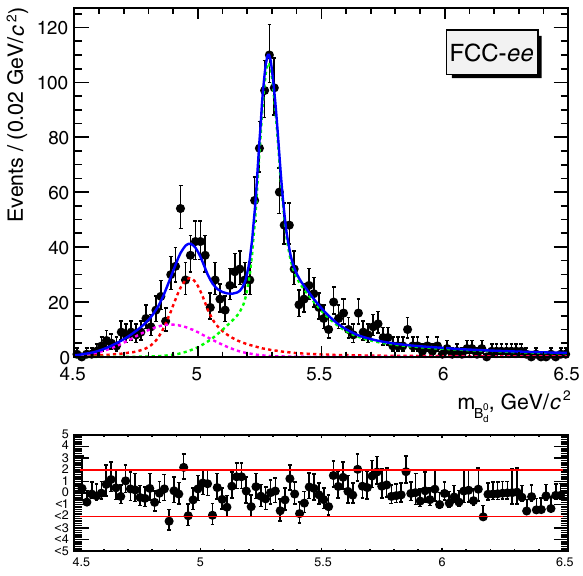
Fig. 2 Invariant mass reconstruction of ¯ B 0 → K ∗ 0 ( 892 )τ + τ − candi- dates.The τ particlesaredecayingintothreeprongs τ − → π − π + π − ν τ allowing the τ decay vertex to be reconstructed. The primary vertex ( Z vertex) is reconstructed from primary tracks and the secondary ver- tex ( ¯ B 0 vertex) is reconstructed thanks to the K ∗ ( 892 ) daughter par- ticles ( K ∗ ( 892 ) → K + π − ). Two dominant sources of backgrounds are included in the analyzed sample, namely ¯ B s → D + s D − s K ∗ 0 ( 892 ) and ¯ B 0 → D + s ¯ K ∗ 0 ( 892 )τ − ¯ ν τ . They are modeled by the red and pink probability density functions (p.d.f.), respectively. The signal p.d.f. is displayed in